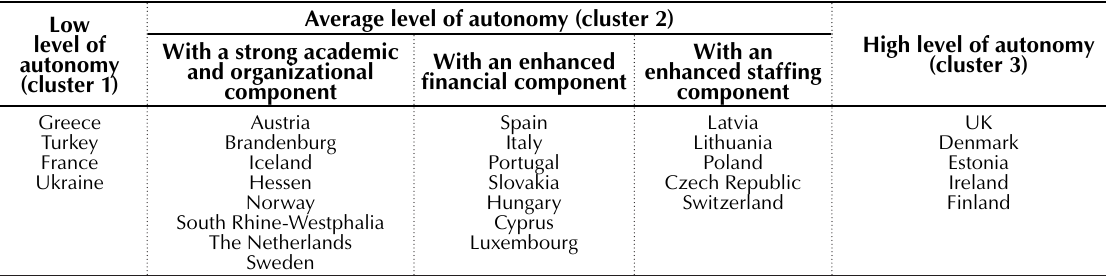
Table 3. Structure of cluster groups by the level of general autonomy Low level of autonomy (cluster 1)